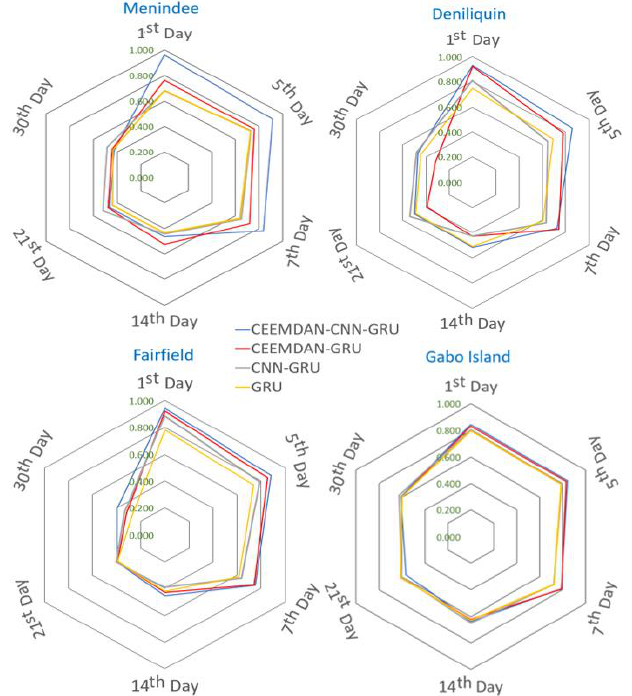
Figure 9. Polar plot showing the Legates and McCabe’s Index (LM) in the testing period computed for the hybrid CEEMDAN-CNN-GRU against comparative models at different n th ( n = 1, 5, 7, 14, 21, and 30) day ahead forecasting of SSM.